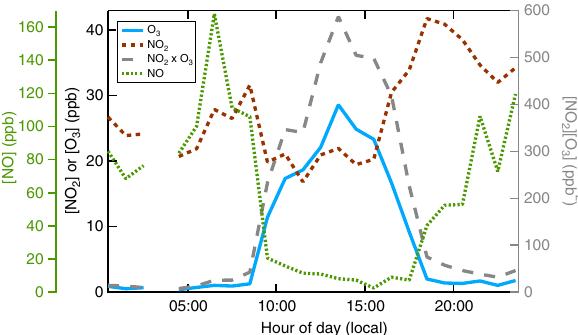
Figure 5. Diurnal profiles for ozone (blue), NO 2 (brown), NO (green), and the product of O 3 and NO 2 (gray) for the first pollution